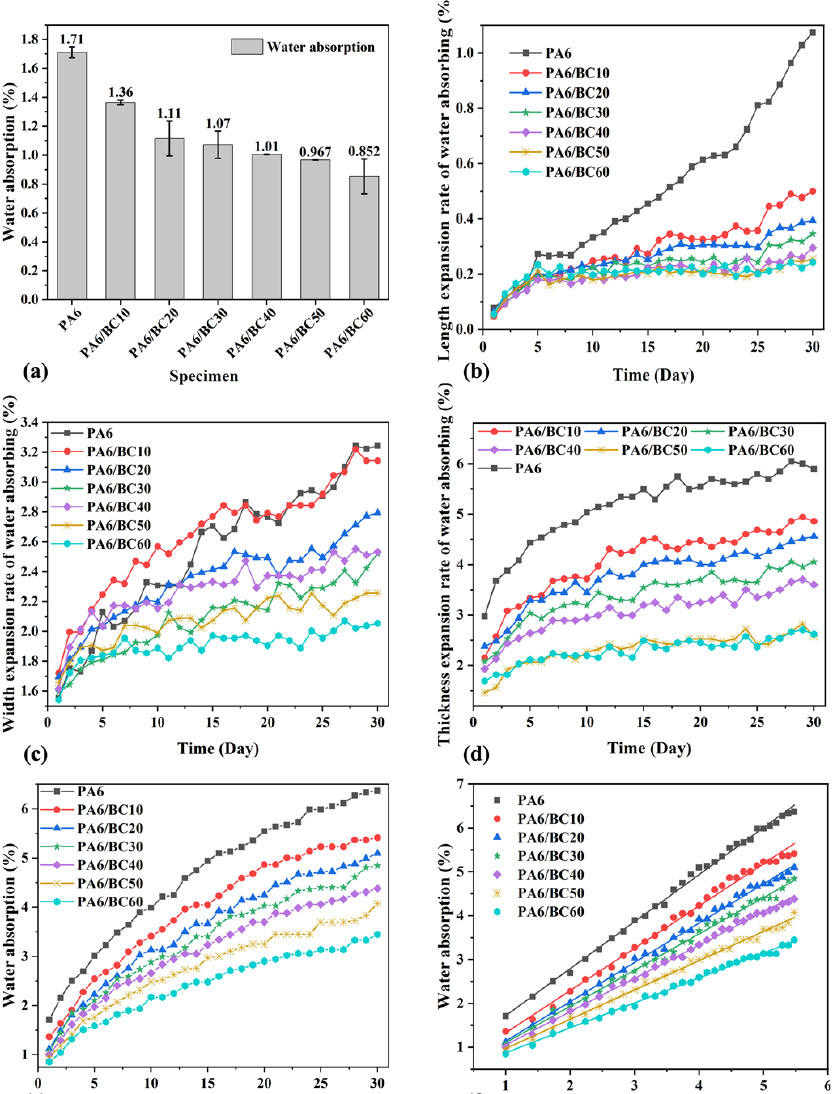
Figure 3. ( a ) The 24 h water absorption rate of the PA6 / BC composites; ( b – d ) length / width / thickness expansion of water absorption for PA6 / BC composites within 30 days; ( e ) water absorption of PA6 / BC composites within 30 days; and ( f ) fitting curves based on Fick’s second law.